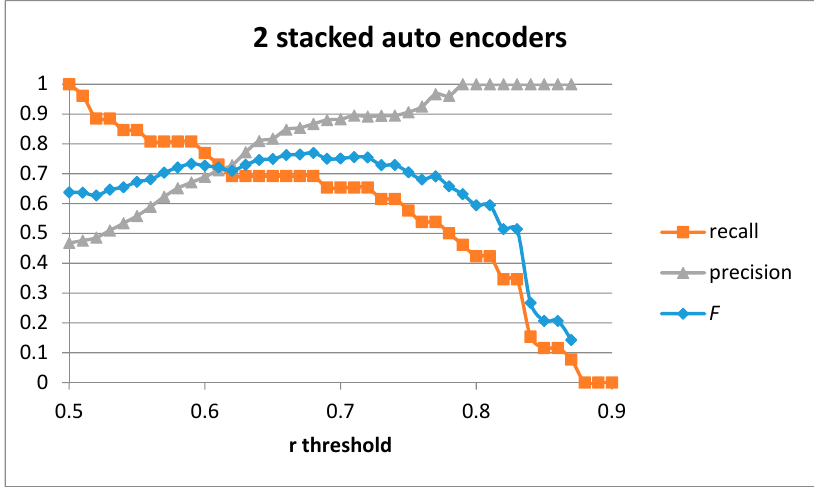
Figure 12. Precision, recall, and F score for two stacked auto-encoders and 100-50 hidden units. Table 10. Classification results for two layers of auto-encoders and recall 0.615. Classified as Ground Truth